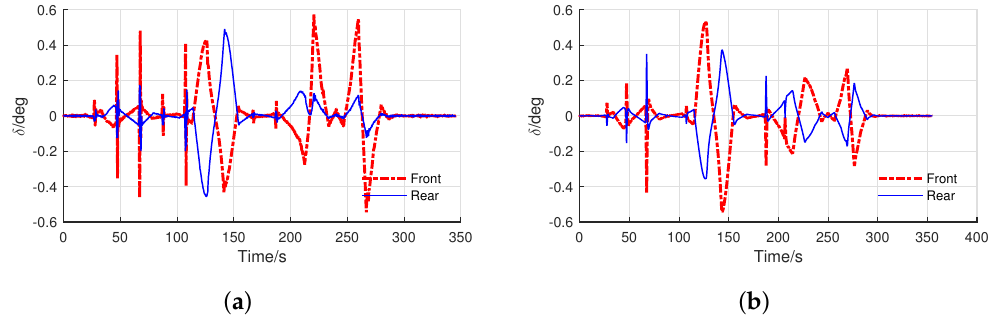
Figure 25. Steering angles of vehicles controlled by different controllers: ( a ) Controller A + ISPFCE and ( b ) Controller B + ISPFCE.